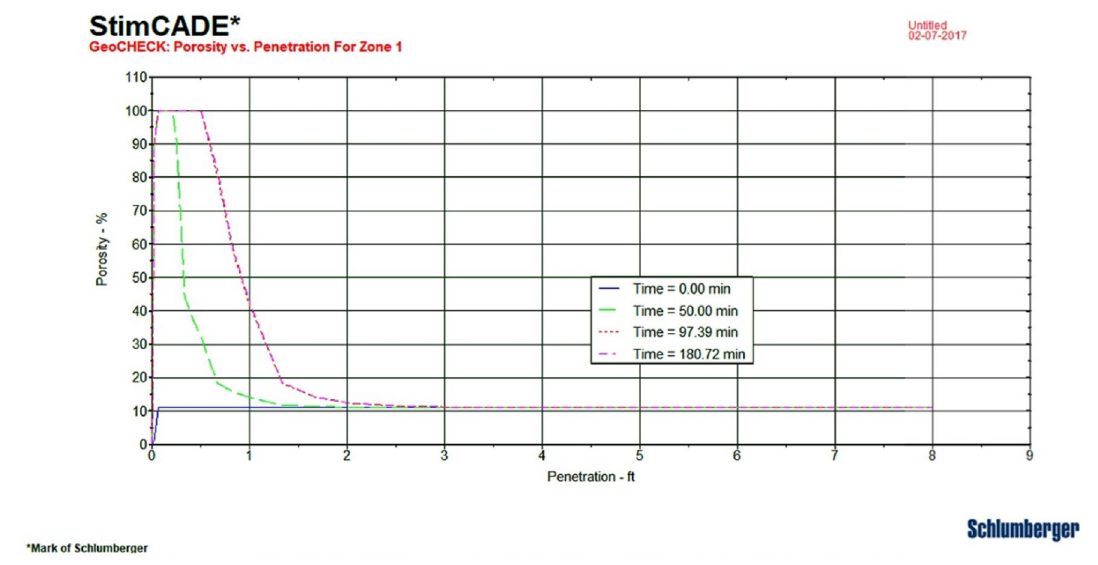
Fig. 9 Porosity alterations versus acid penetration depth